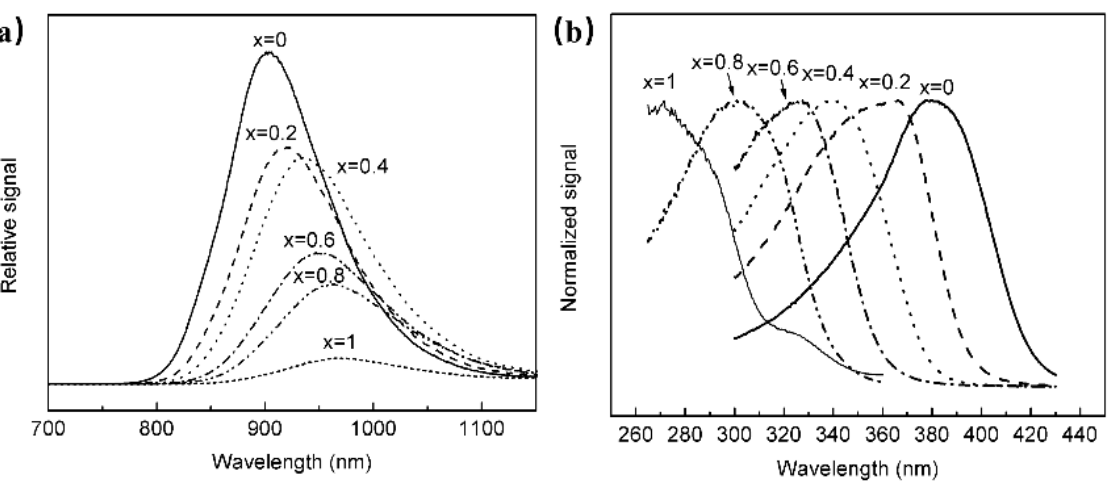
Figure 11. ( a ) PL spectra of Ba 1 − x Sr x Sn x O 3 (Ex = 380 nm). ( b ) PLE spectra of Ba 1 − x Sr x Sn x O 3 (Em = 905 nm).